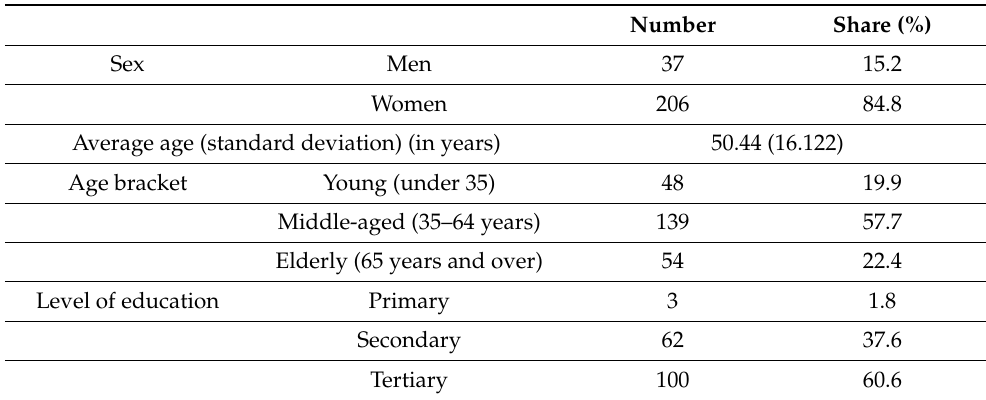
Table 1. Last Aid participants—sociodemographic